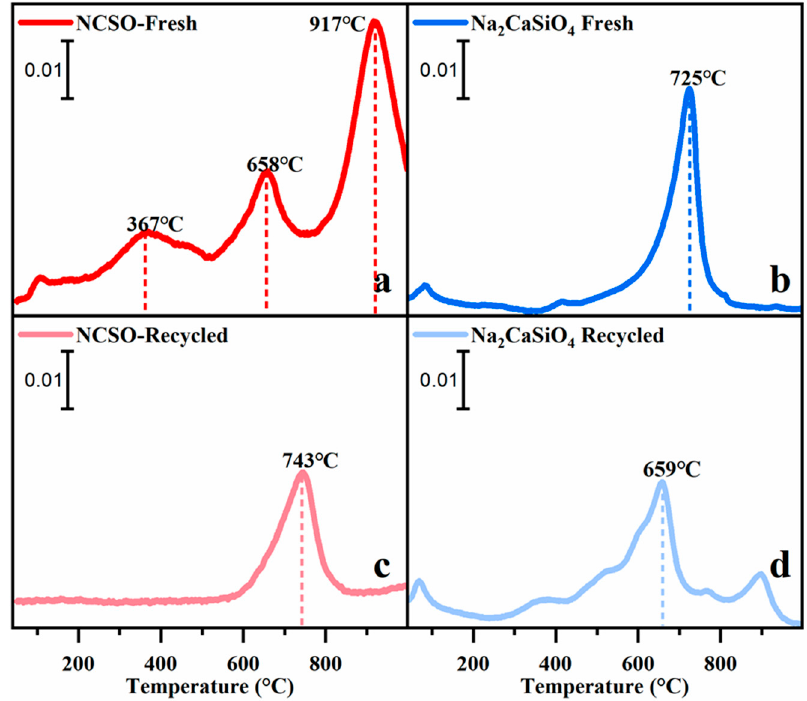
Figure 6. CO 2 -TPD of NCSO and Na 2 CaSiO 4 : ( a ) fresh NCSO; ( b ) recycled NCSO (12 cycles); ( c ) fresh Na 2 CaSiO 4 ; ( d ) recycled Na 2 CaSiO 4 (5 cycles).